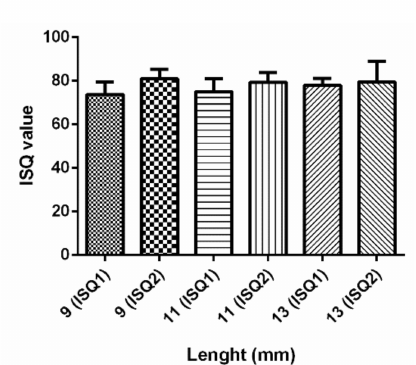
Figure 2. ISQ 1 and 2 values distribution within different implant diameters (3.5 and 4 mm).